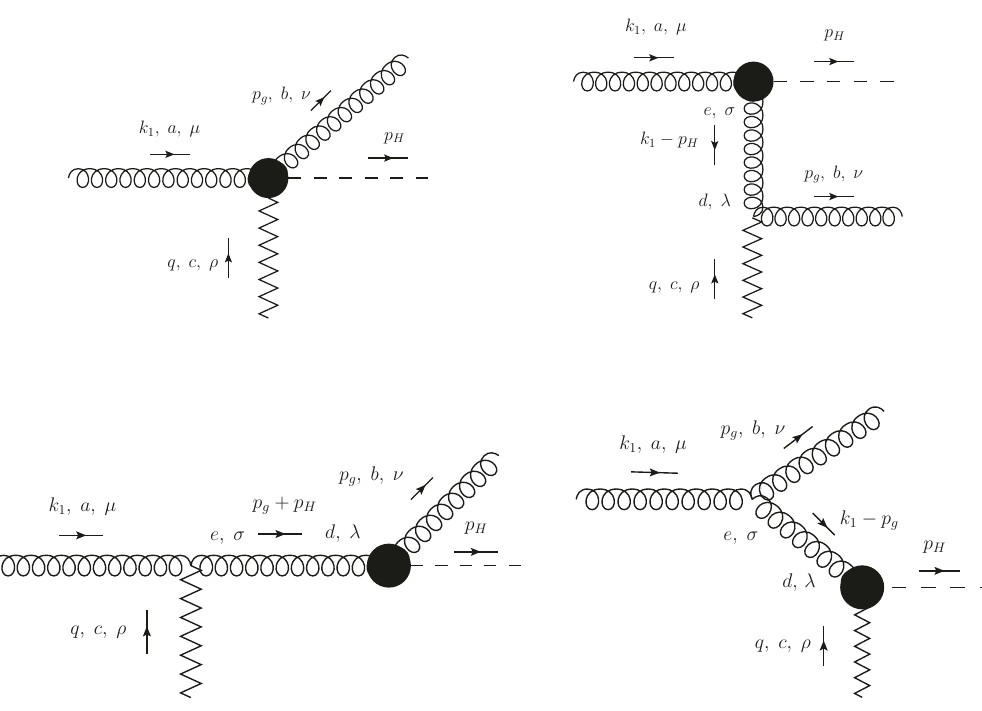
Figure 8 . Feynman diagrams contributing to the gR → gH amplitude. In the text we label them from (1) to (4) starting from the top